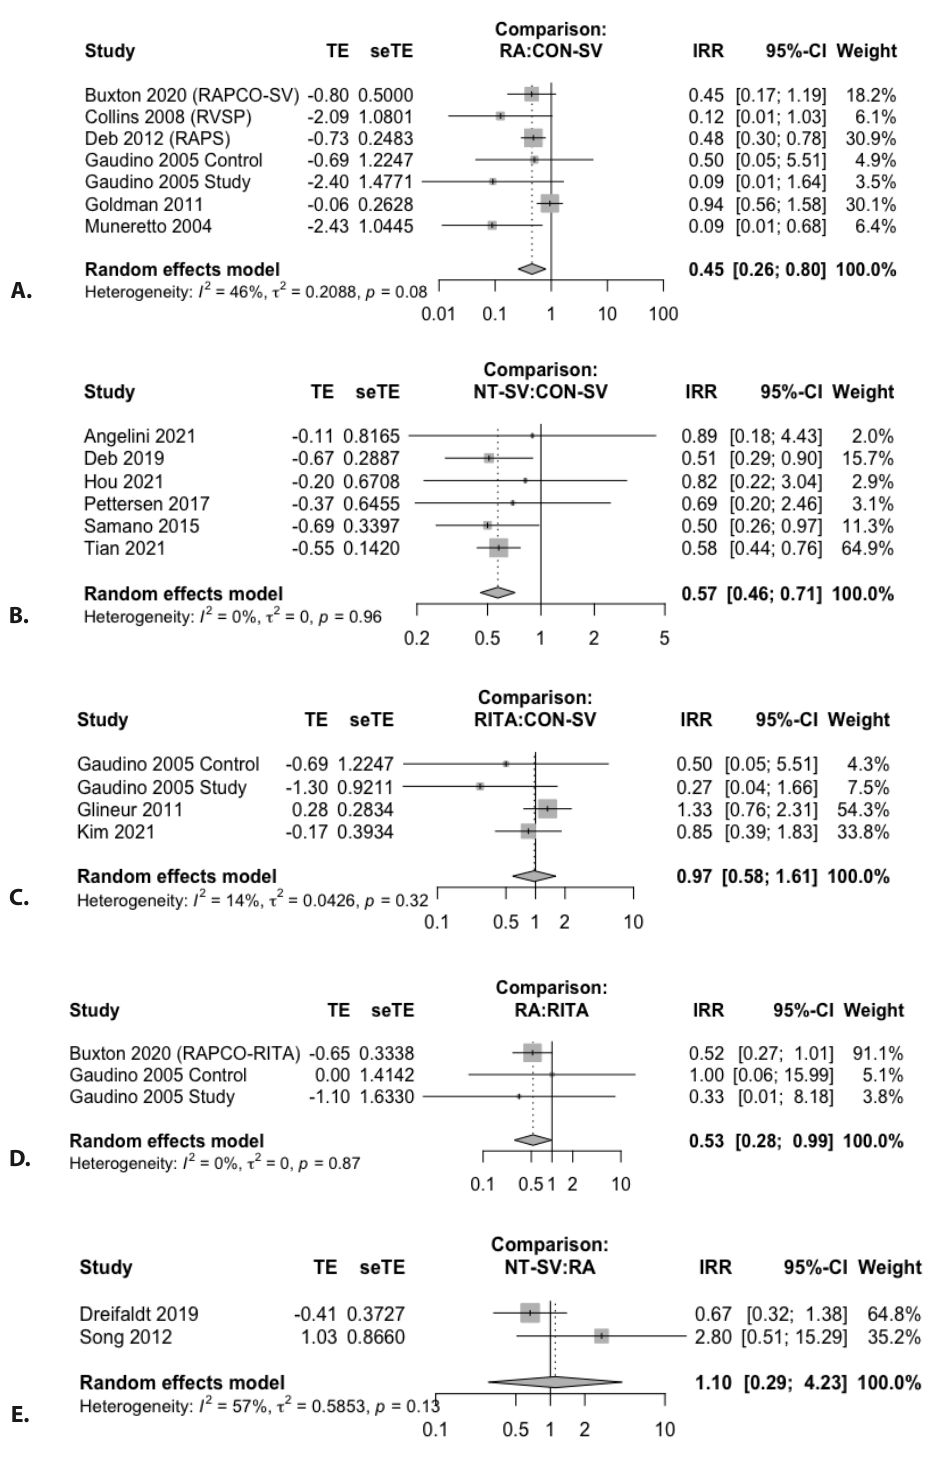
Fig. S2 - Forest plot for the pairwise comparison of graft occlusion for A) radial artery (RA) vs. conventionally harvested saphenous vein (CON- SV); B) no-touch saphenous vein (NT-SV) vs. CON-SV; C) right internal thoracic artery (RITA) vs. CON-SV; D) RA vs. RITA; E) and NT-SV vs. RA. CI=confidence interval; IRR=incidence rate ratio; RAPCO=Radial Artery Patency and Clinical Outcomes; RAPS=Radial Artery Patency Study; RSVP=Radial Artery Versus Saphenous Vein Patency; SAVE-RITA=Saphenous Vein versus Right Internal Thoracic Artery; seTE=standard error of treatment estimate; SV=saphenous vein; TE=estimate of treatment effect, e.g., log hazard ratio or risk